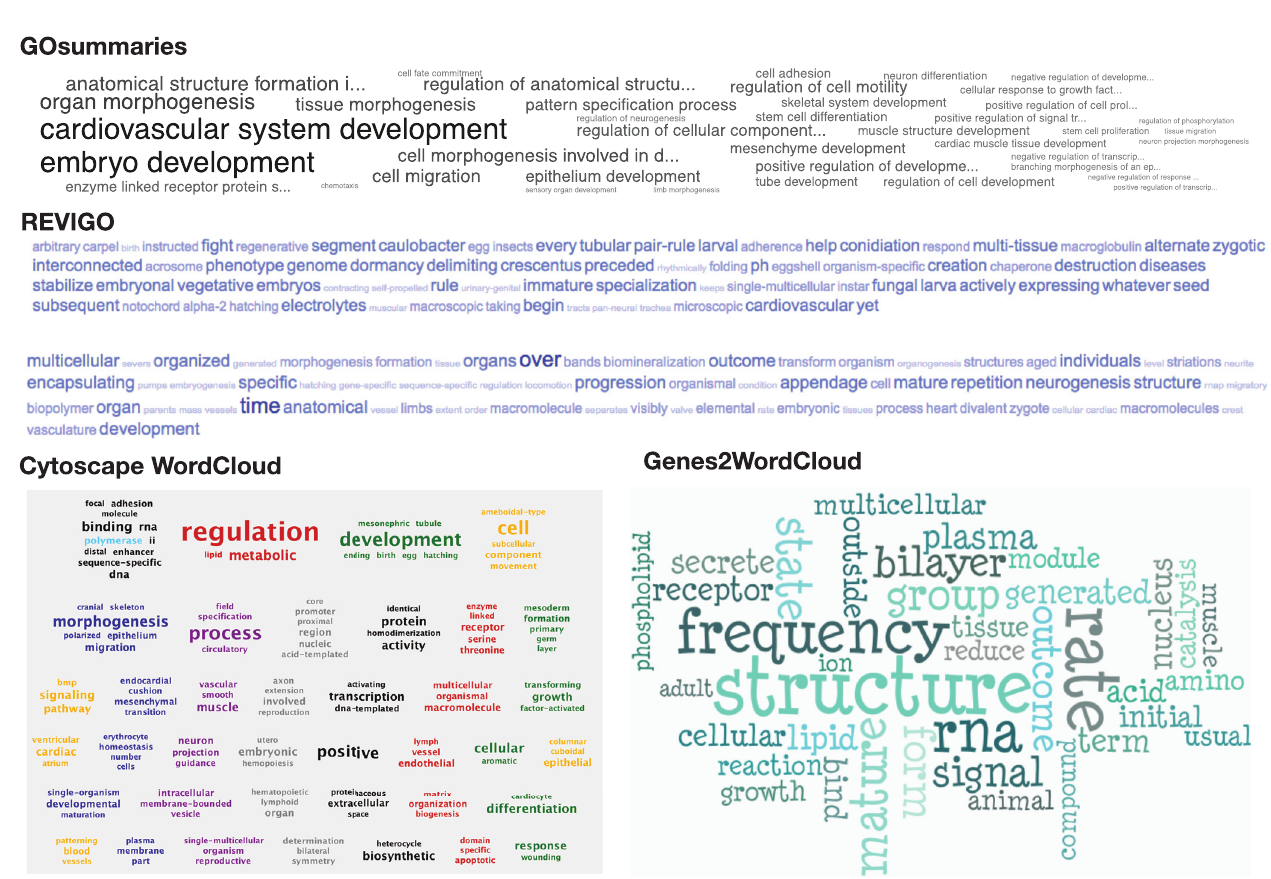
Figure 1. Word clouds describing the same set of genes, created by various